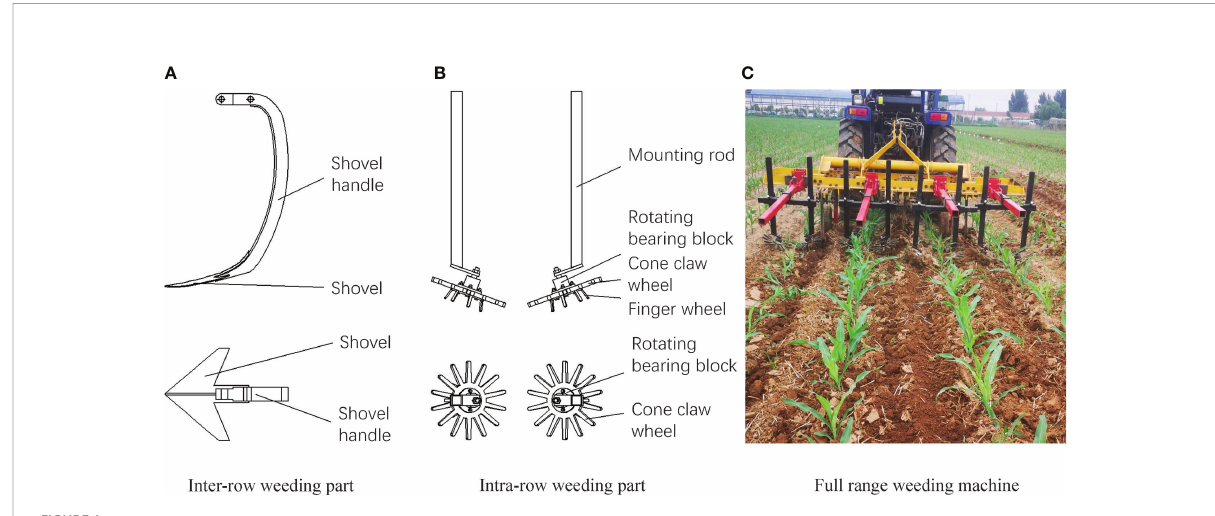
FIGURE 1 Experimental weeding parts and machine (A) , inter-row weeding part (B) , intra-row weeding part and (C) , full range weeding